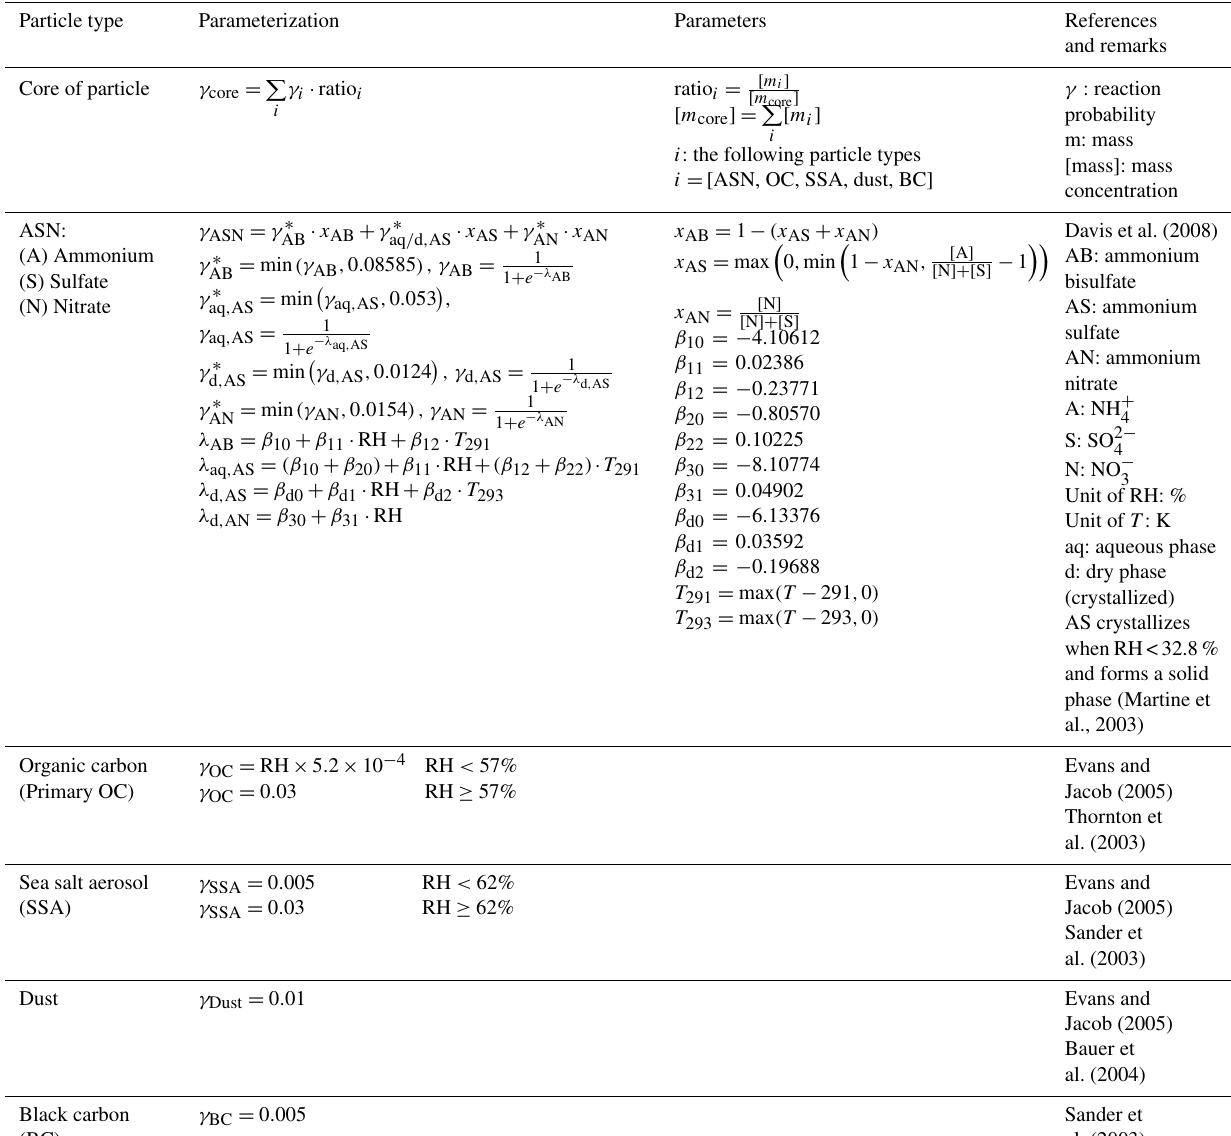
Table 1. Representation of the reaction probability of aerosol particle core ( γ core ) for N 2 O 5 hydrolysis. Particle